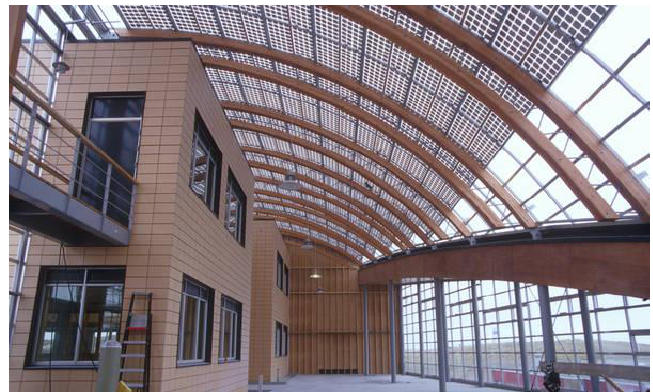
Figure 5. Skylight with monocrystalline PV modules [65].